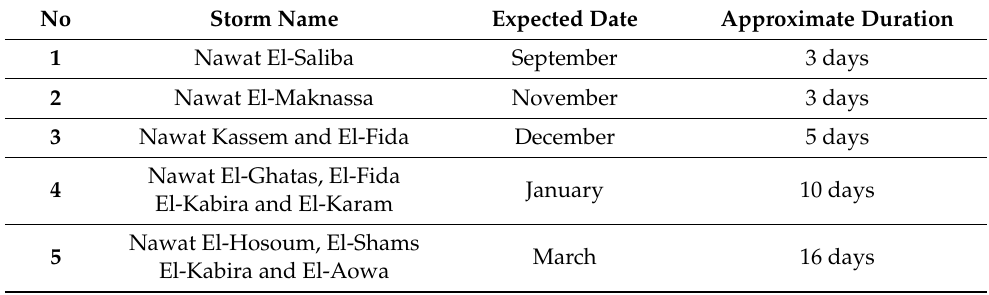
Table 1. Some recorded heavy storms in Alexandria with expected dates and durations. From